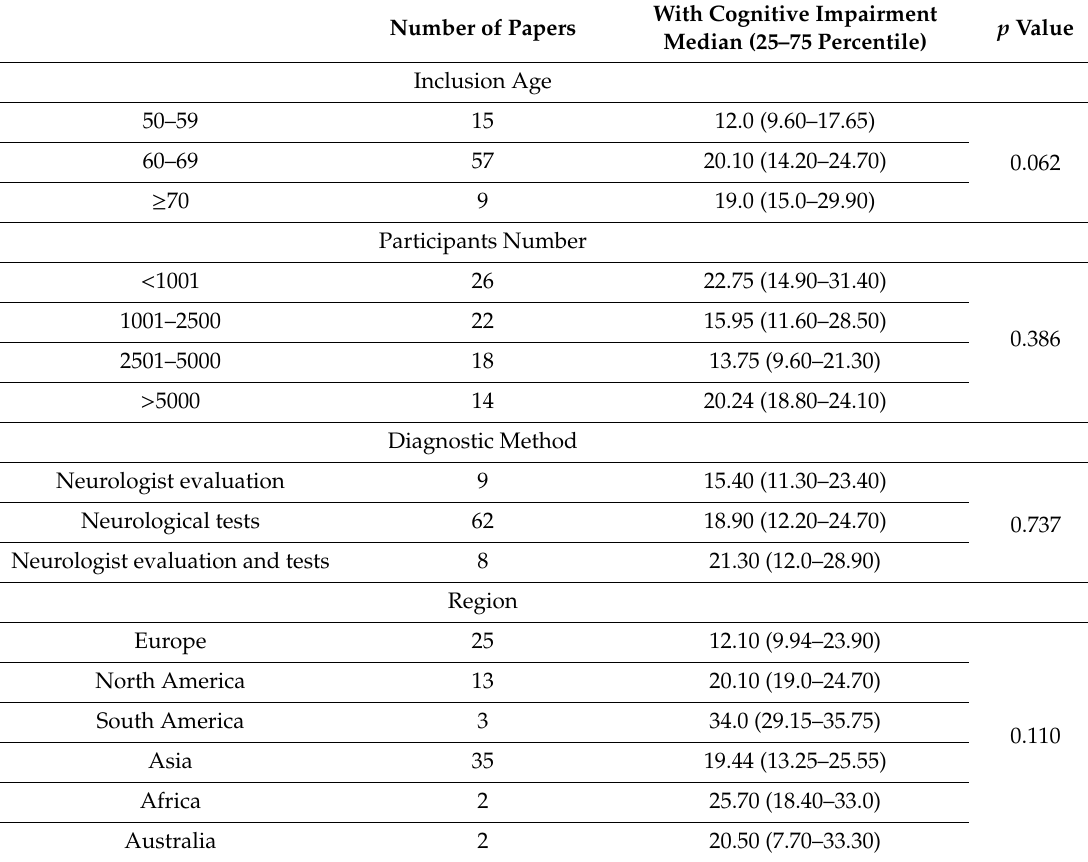
Table 1. Summary of the prevalence of cognitive impairment reported by 80 studies included in